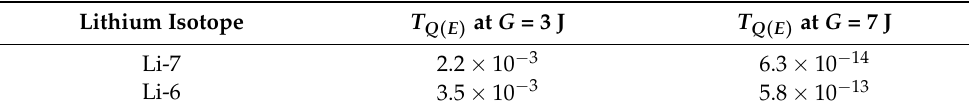
from the value at G = 3 J to the value at G = 7 J according to the setting values in graph (a) of Figure